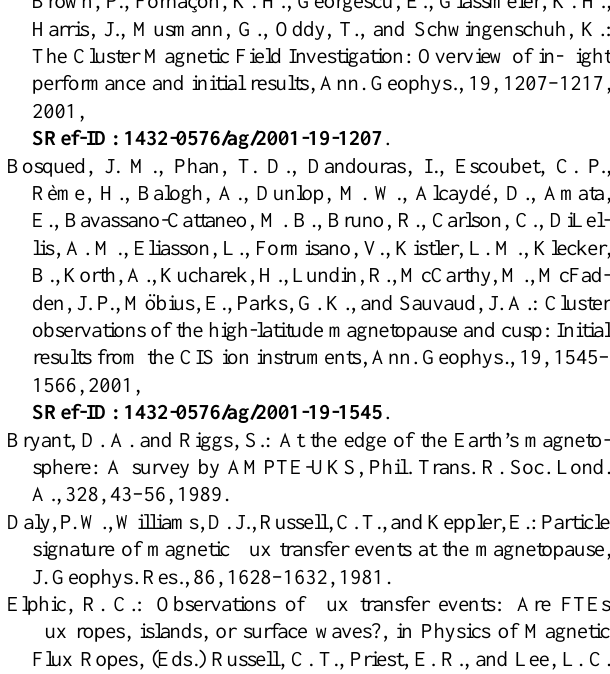
Fig. 10. A sketch of the boundary layer structure, and the rela- tive paths of the spacecraft at 10:52 UT. Clusters 1 and 4 were in the magneosheath and passed through an FTE. Cluster 3 was also in the magnetosheath but further from the magnetopause and ob- served only field line draping. Cluster 2 was in the inner boundary layer, but entered the outer boundary layer as the FTE passed, lead- ing to characteristic plasma and magnetic field signatures, but with no bipolar B N signature. Cluster 2 observed similar signatures at 10:52 UT to those observed by Cluster 3 at 10:08